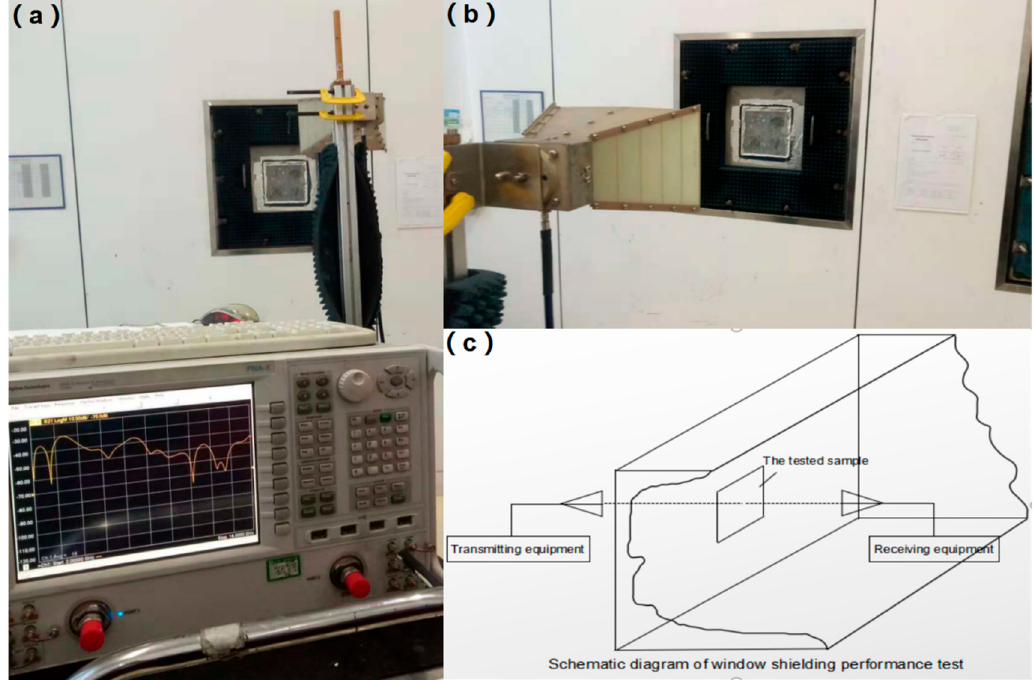
Figure 4. Physical pictures of shielded chamber measurement ( a , b ), and measurement configuration diagram of shielded chamber method ( c ).